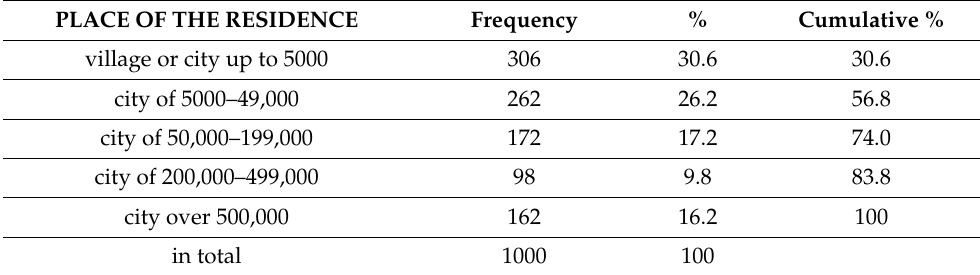
Table 4. Place of residence of the